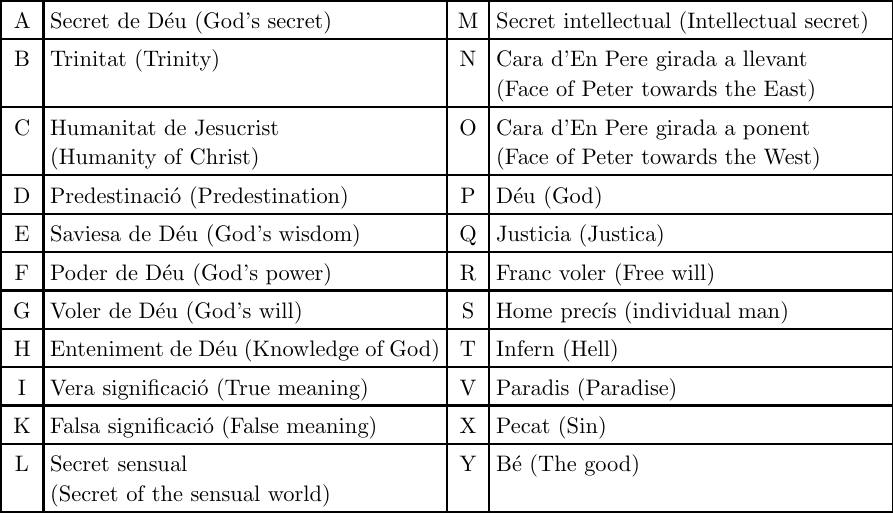
Figure 2. Table of fundamental notions, Chapter 335 (Llull, 1957–60), Vol. 2, p.